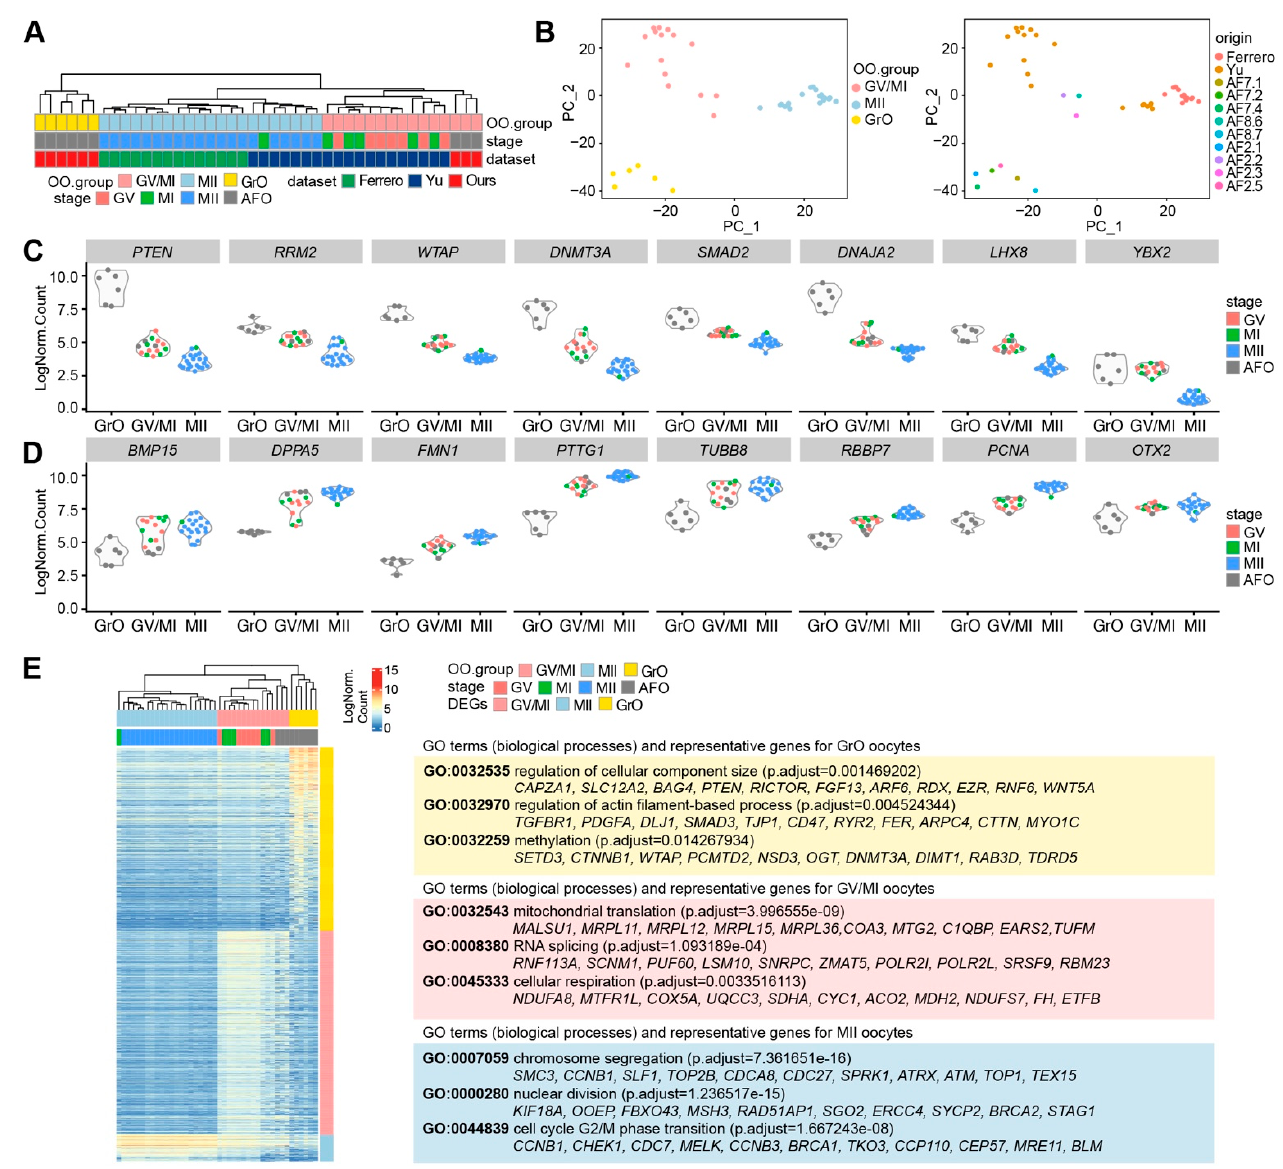
Figure 3. Transcriptional analysis of oocytes from antral follicles. ( A ) Hierarchical clustering of oocytes from antral follicles (AFO) and oocytes in GV, MI, and MII stage from published datasets, based on the 100 most highly variable expressed genes; ( B ) Principal Component Analysis (PCA) of AFO, GV, MI, and MII oocytes colored by oocyte groups (left panel) and oocyte origins (right panel); ( C ) Violin plots of selected genes showing decreasing expression from the GrO to the MII group; ( D ) Violin plots of selected genes showing increasing expression from the GrO to the MII group; ( E ) Heatmap showing differentially expressed genes in the OO.groups and several representative GO terms (biological processes) and associated genes (see Supplementary Table S2).